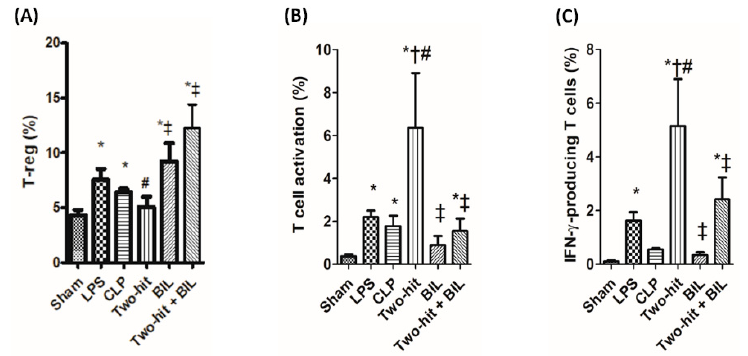
Figure 5. Bilirubin affects the recruitment of T-reg and the functions of T-cells in the blood in the “two-hit” sepsis model. Mice were administered i.p. LPS at 5 mg/kg body weight on day 0. After 24 h, the mice were challenged with cecal ligation and puncture (CLP: 25-gauge needle and double-puncture). Next, the mice were administered bilirubin at 30 mg/kg body weight. The mice were sacrificed 24 h